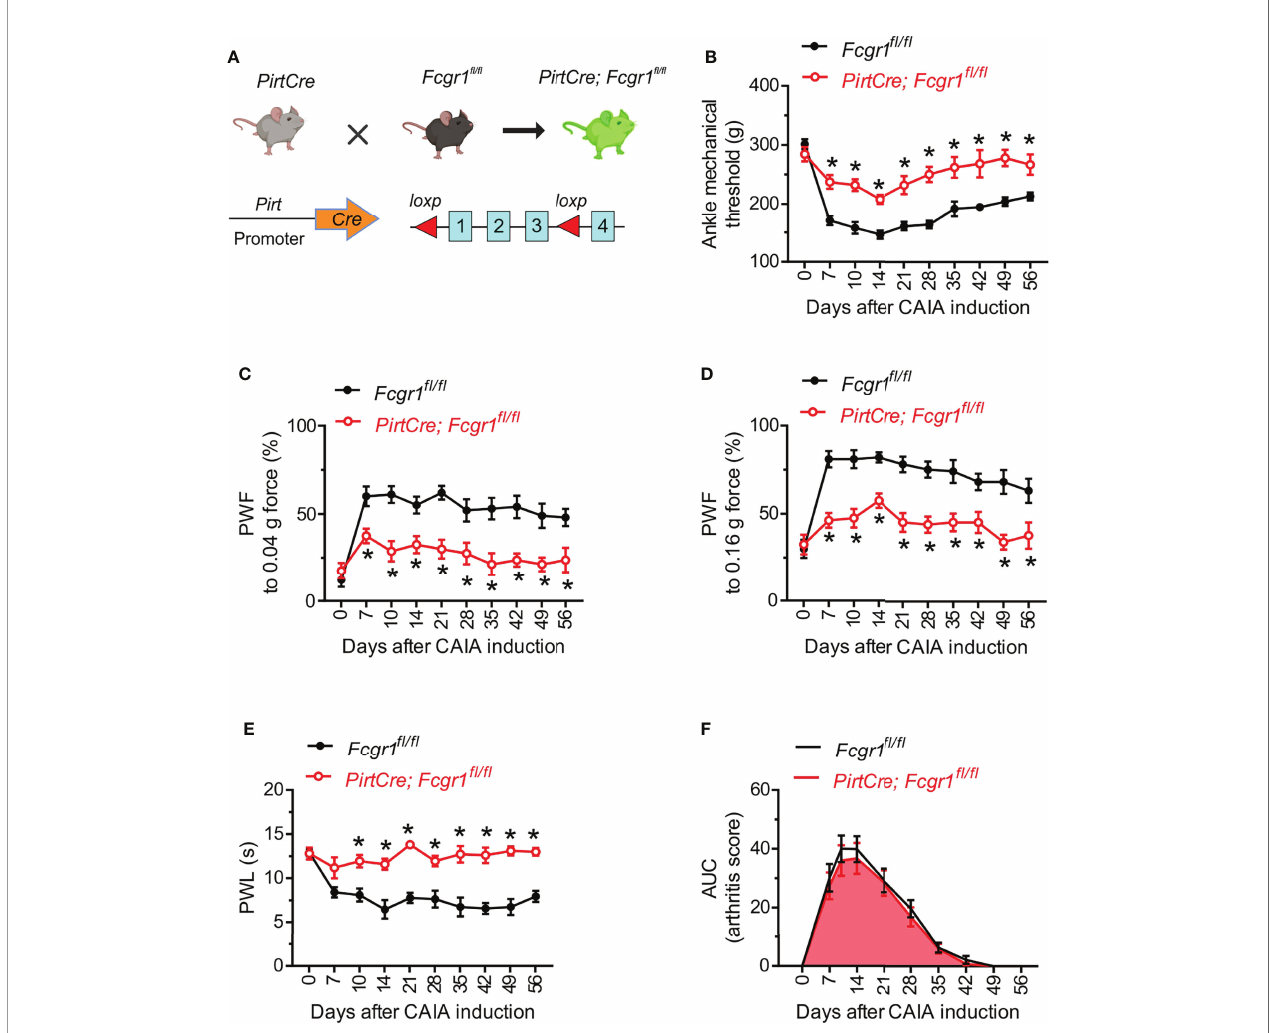
FIGURE 3 | Neuronal Fc g RI mediates arthritis pain in the late phase of the CAIA model. (A) Strategy for the generation of primary sensory neuron speci fi c Fcgr1 knockout mice. Two loxp sites were inserted 5 ’ to exon 1 and 3 ’ to exon 3 of the Fcgr1 gene, respectively. Deletion of the Fcgr1 gene in primary sensory neurons was achieved by mating Fcgr1 fl / fl mice with a PirtCre mouse line. (B, E) Time course of ankle mechanical threshold (B) , paw withdrawal frequency (PWF) to 0.04 g (C) and 0.16 g force (D) , and paw withdrawal latency (PWL) to radiant heat in the hind paw (E) in PirtCre- Fcgr1 fl / fl mice and Fcgr1 fl / fl control littermates following CAIA. n = 8-10 mice per group for (B – D) ; n = 5-6 mice per group for (E) ; *p < 0.05 versus Fcgr1 fl / fl controls; two-way repeated measures ANOVA followed by Bonferroni correction. (F) Time course of arthritis score (area under the curve; AUC) of PirtCre-Fcgr1 fl / fl mice and Fcgr1 fl / fl control littermates in the CAIA model. n = 14-15 mice per group; P > 0.05 versus Fcgr1 fl / fl ; two-way repeated measures ANOVA followed by Bonferroni